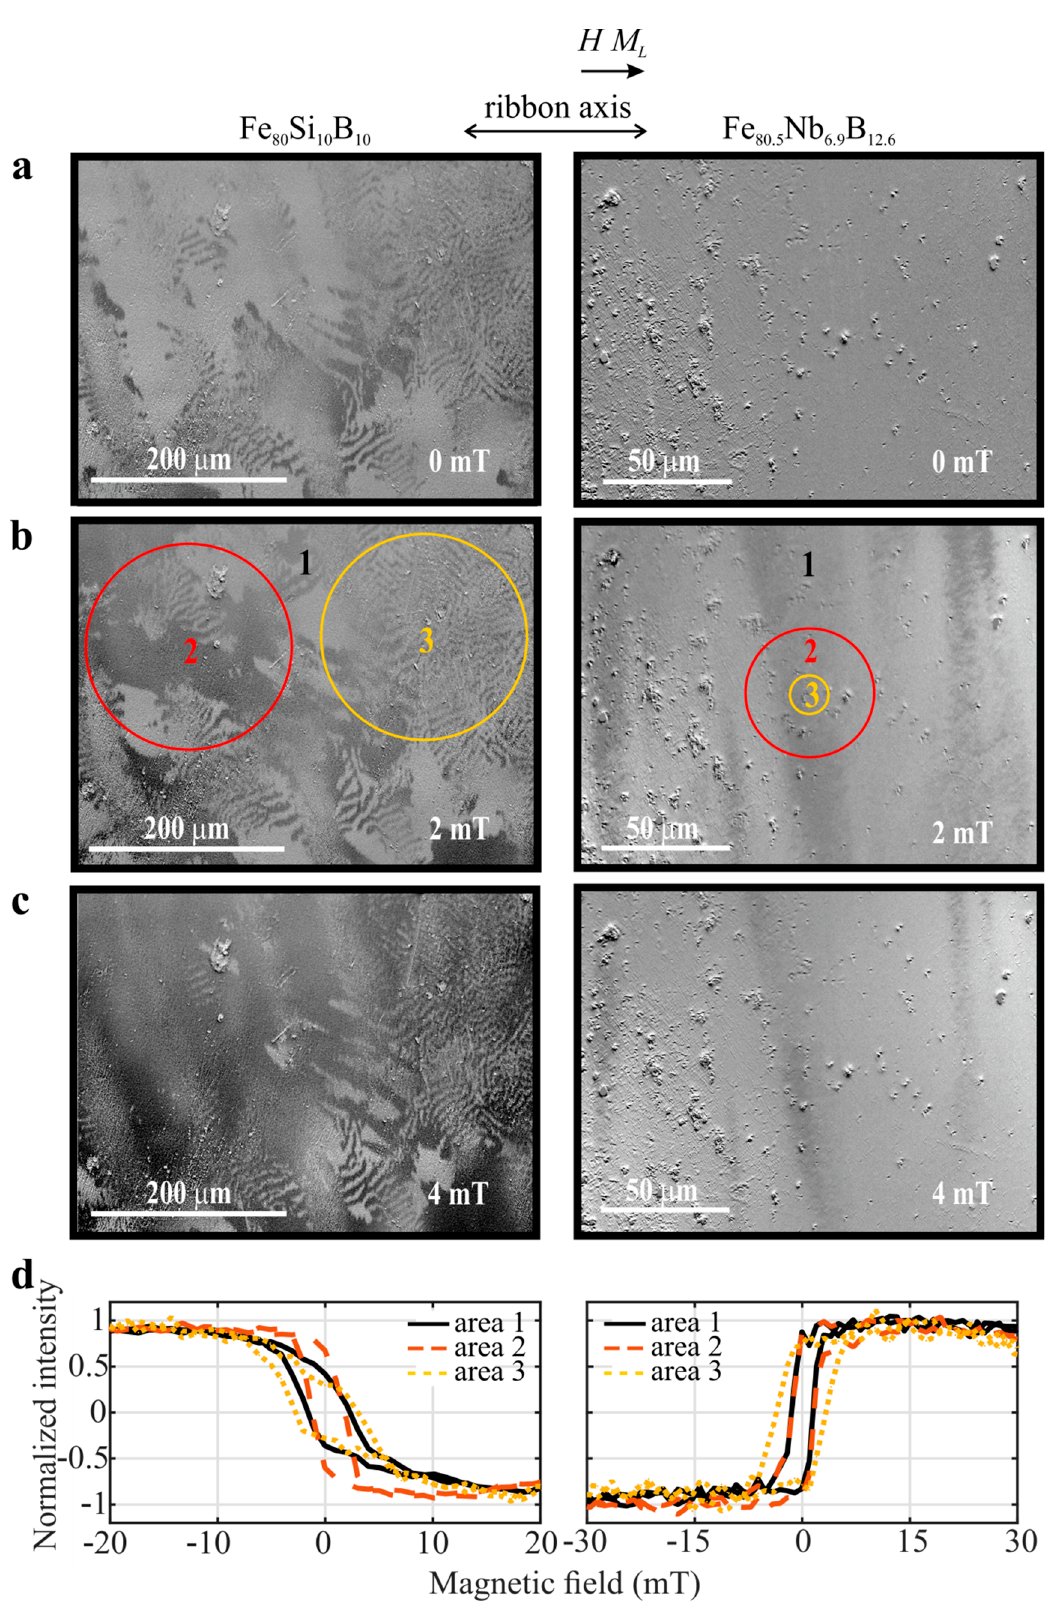
Figure 6. Magneto-optical measurements of the surface-crystalline Fe 80 Si 0 B 10 (left panel) and Fe 80.5 Nb 6.9 B 12.6 (right panel) ribbons. Magnetic domain patterns are visualized at applied magnetic fields 0 mT ( a ), 2 mT ( b ), and 4 mT ( c ). Hysteresis loops corresponding to the highlighted surface areas are shown in bottom subplots ( d ). The illustration of domains for the Fe 80 Si 0 B 10 (top) and Fe 80.5 Nb 6.9 B 12.6 (bottom) in Fig- ure 7 was obtained using magnetic force microscopy in a higher resolution. The magnetic